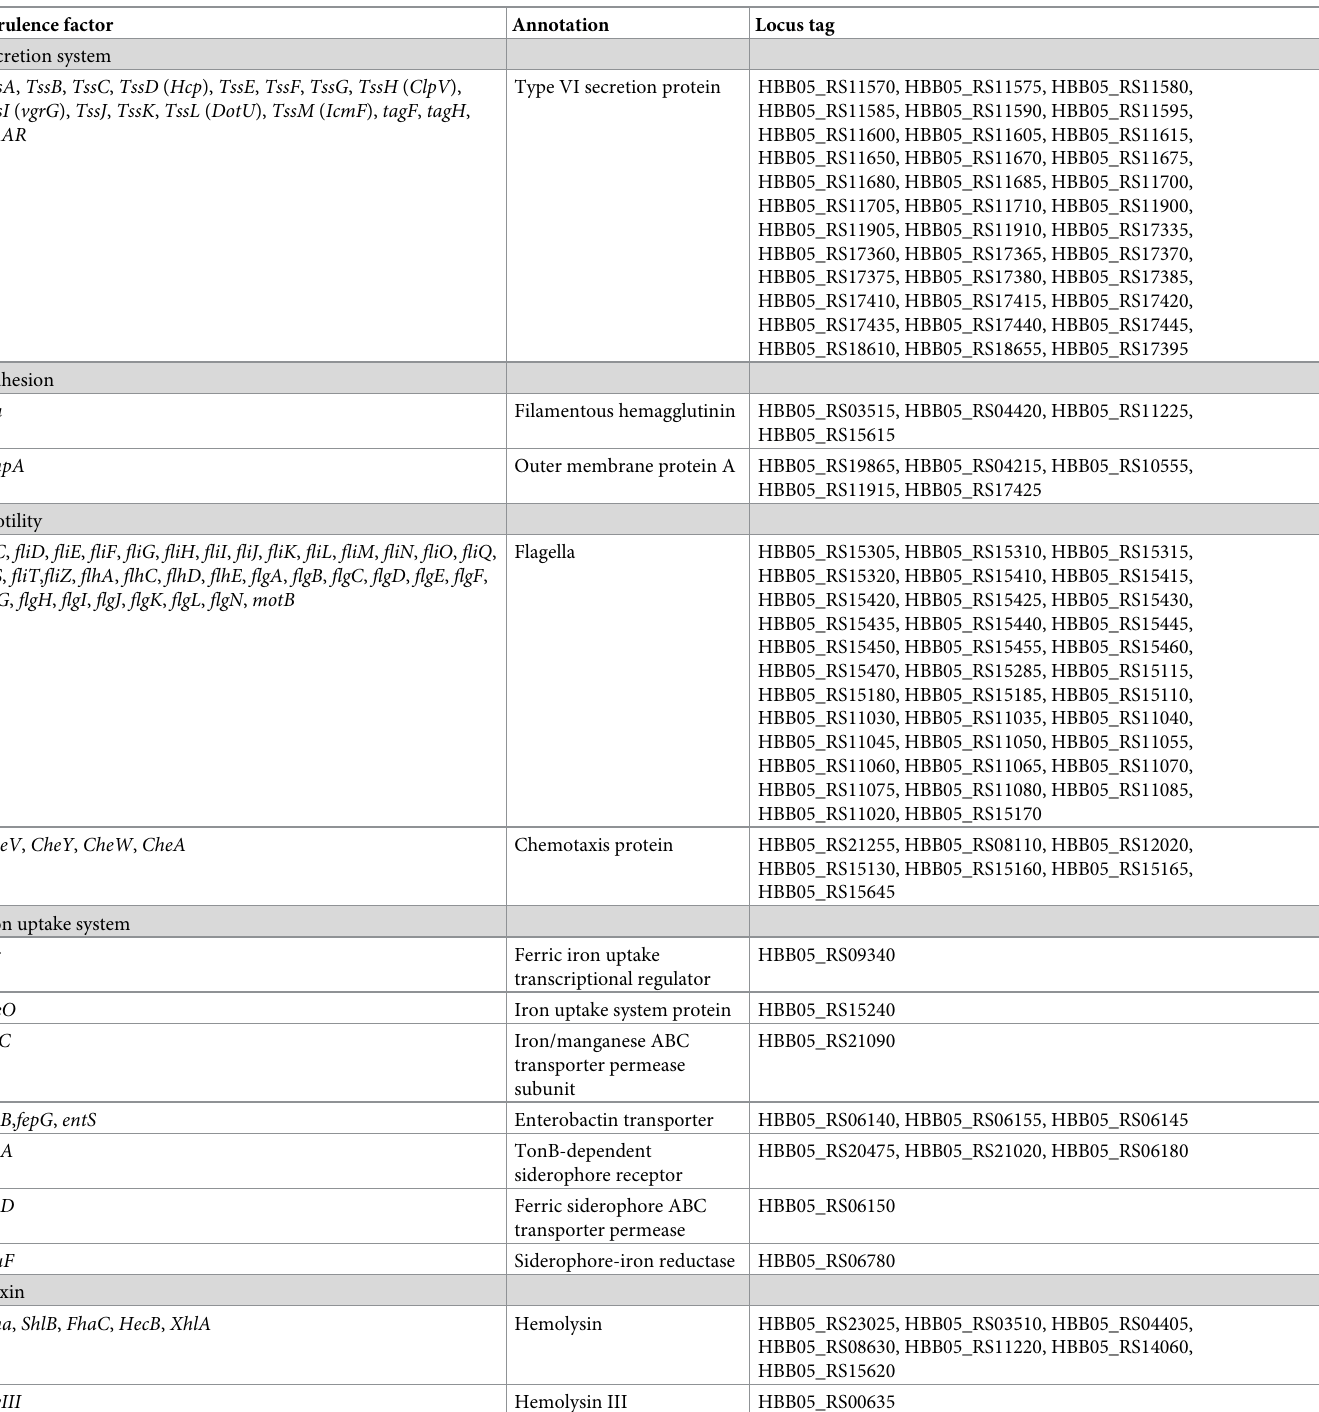
Table 3. Virulence factors of P . agglomerans